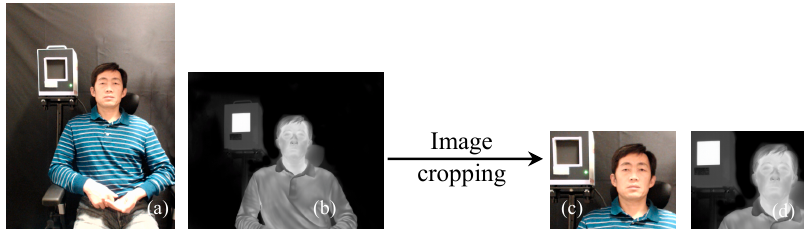
Figure 12. Sizes of images used for registration: ( a ) full size visible image, 640 × 480 pixels; ( b ) full size IR image, 512 × 640 pixels; ( c ) cropped visible image, 240 × 320 pixels; ( d ) cropped IR image, 240 × 320 pixels.